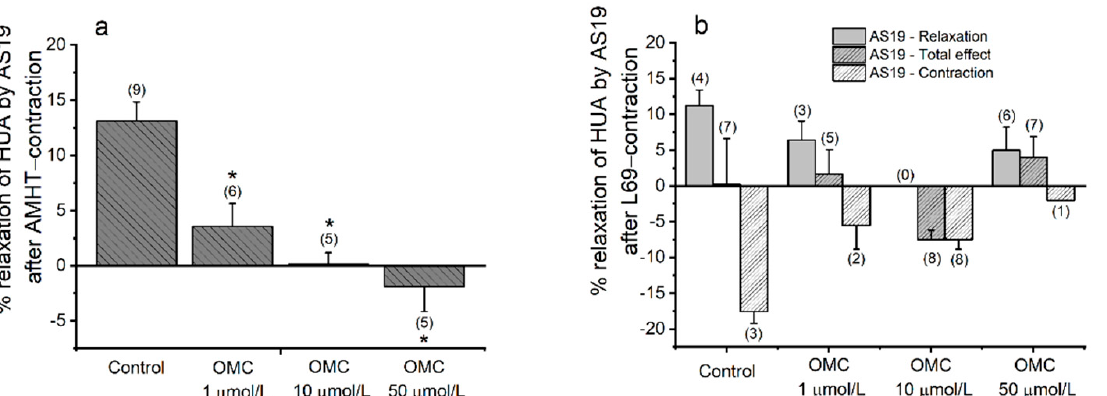
Figure 4. Percentage of relaxation of the human umbilical (HUA)-rings incubated with octylmethox- ycinnamate (OMC), contracted by ( a ) alpha-methyl-5-hydroxytryptamine (AMHT, 5-HT 2A agonist; 1 μ mol/L), and by ( b ) L-694247 (L69, 5-HT 1B/D agonist; 1 μ mol/L) and relaxed by the agonist of the 5- HT 7 receptor, AS19 (1 μ mol/L). In Figure 4B, the dual effect of L69 is represented for three bars: relaxation (left), contraction (right), and the total effect (middle). Each bar represents the mean, ver- tical lines represent the S.E.M. and the number within brackets is n . * Represents a significant dif- ference when compared to rings from the HUA control ( p < 0.05).